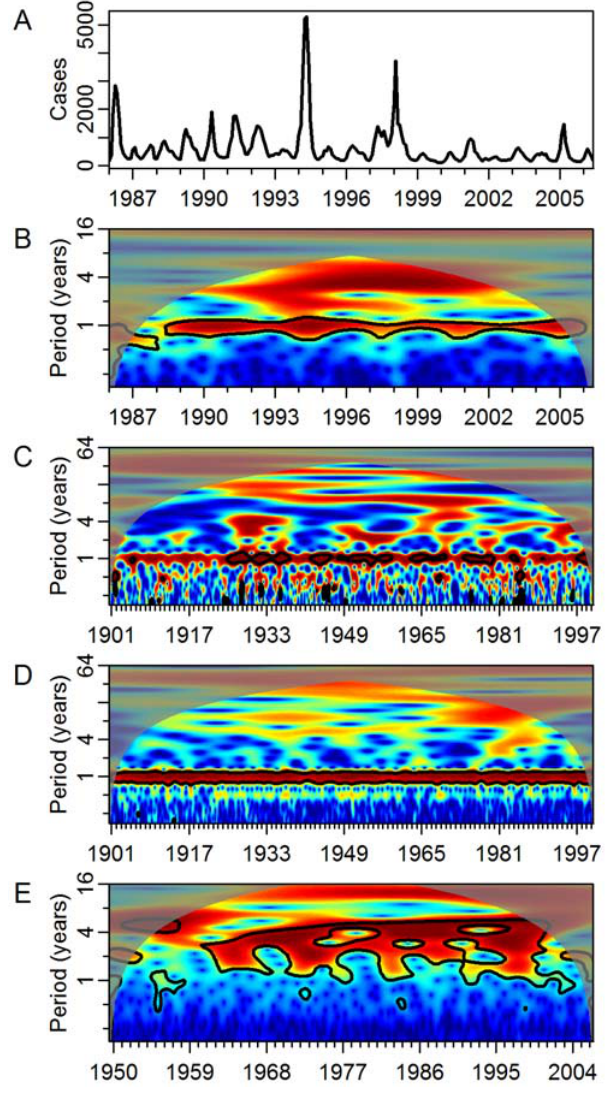
Figure 1. Wavelet spectra of dengue, temperature, and precipitation in Puerto Rico and ENSO. (A) Reported cases of dengue in Puerto Rico by month. (B) Wavelet spectrum of (A). Power increases from blue to red. Areas where power is significantly high (95% confidence level) are encircled by black lines. Shaded areas indicate the presence of significant edge effects. (C) Wavelet spectrum of monthly average mean temperature in Puerto Rico (average minimum and maximum temperature behave similarly to mean temperature and are not shown). (D) Wavelet spectrum of monthly cumulative precipitation in Puerto Rico. (E) Wavelet spectrum of